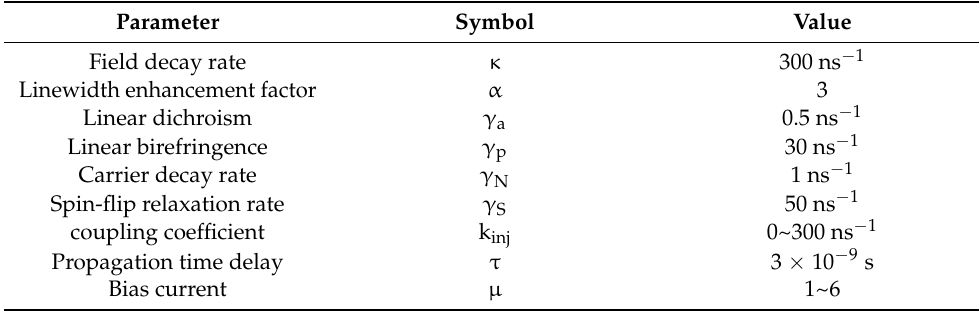
Table 1. VCSEL parameters and values used in